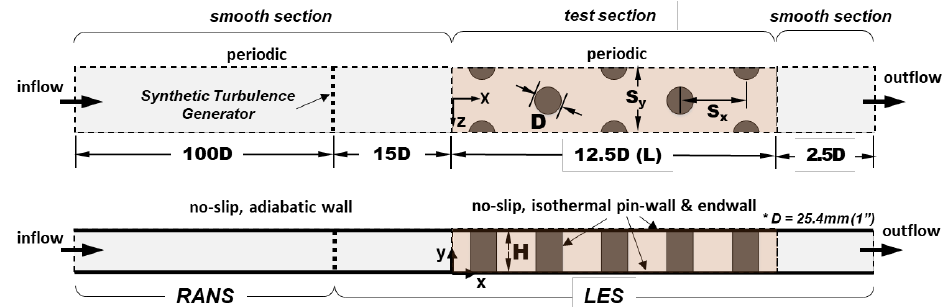
Figure 1. Schematic of cooling channel studied. Table 1. Summary of simulations performed *.